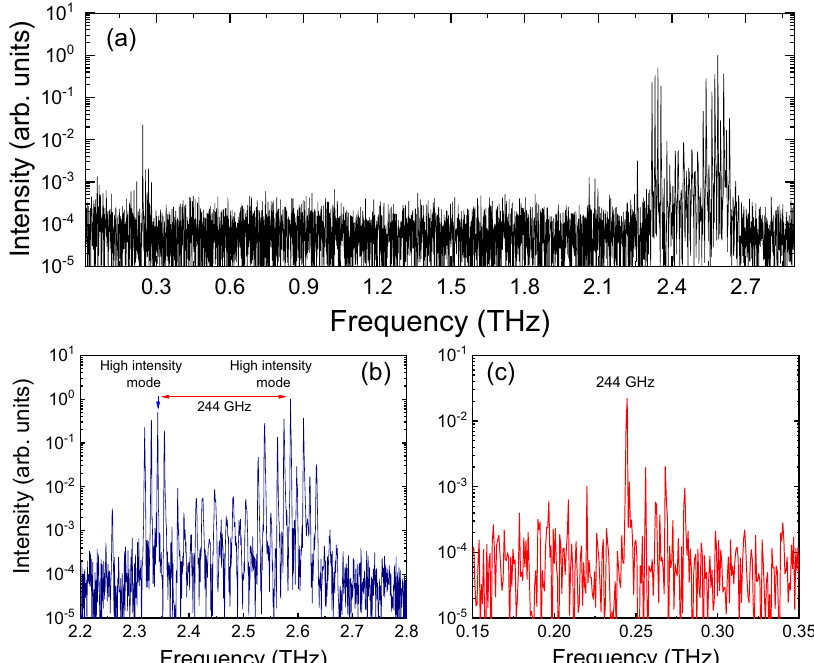
Fig. 5 mmWave emission engineering from QCL 3 . a Full spectrum showing THz emission split in two spectral bands around 2.45 THz using an integrated GTI. Nonlinear mmWave generation centred at 244 GHz is observed. b Enhanced view of THz emission showing the two spectral bands with mode separation of 14 GHz. c Enhanced view of nonlinear mmWave emission showing emission centred at 244GHz. The QCL is driven in pulsed mode (10% duty cycle) and at a fi xed heat sink temperature of 10 K.